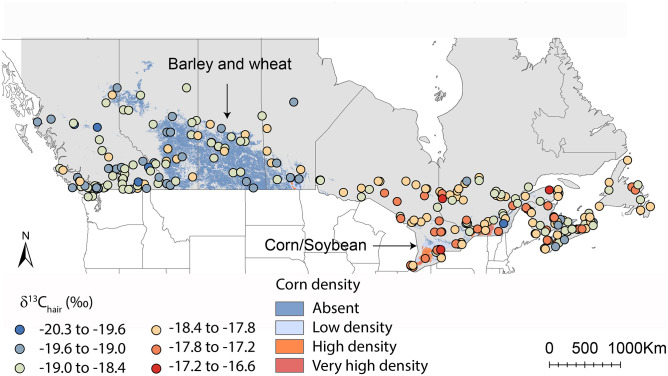
Distribution of carbon isotope variations in hair of donors and density of corn production across Canada.Color scale represents the spatial density of corn crops on agricultural land relative to other C3 crops for the year 2011 (http://open.canada.ca/data). This map contains information licensed under the Open Government Licence–Canada. Administrative boundaries are from http://www.naturalearthdata.com/. This map was generated in Rx64 3 4.2 (https://www.r-project.org/).